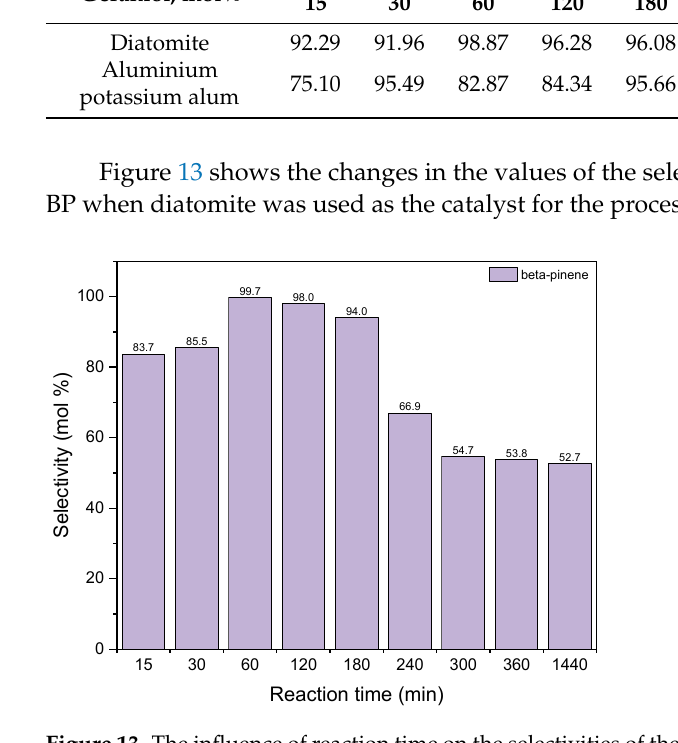
Figure 13. The influence of reaction time on the selectivities of the appropriate product over diatomite as the catalyst.